Question: Which kind of chart has been used to present this data?
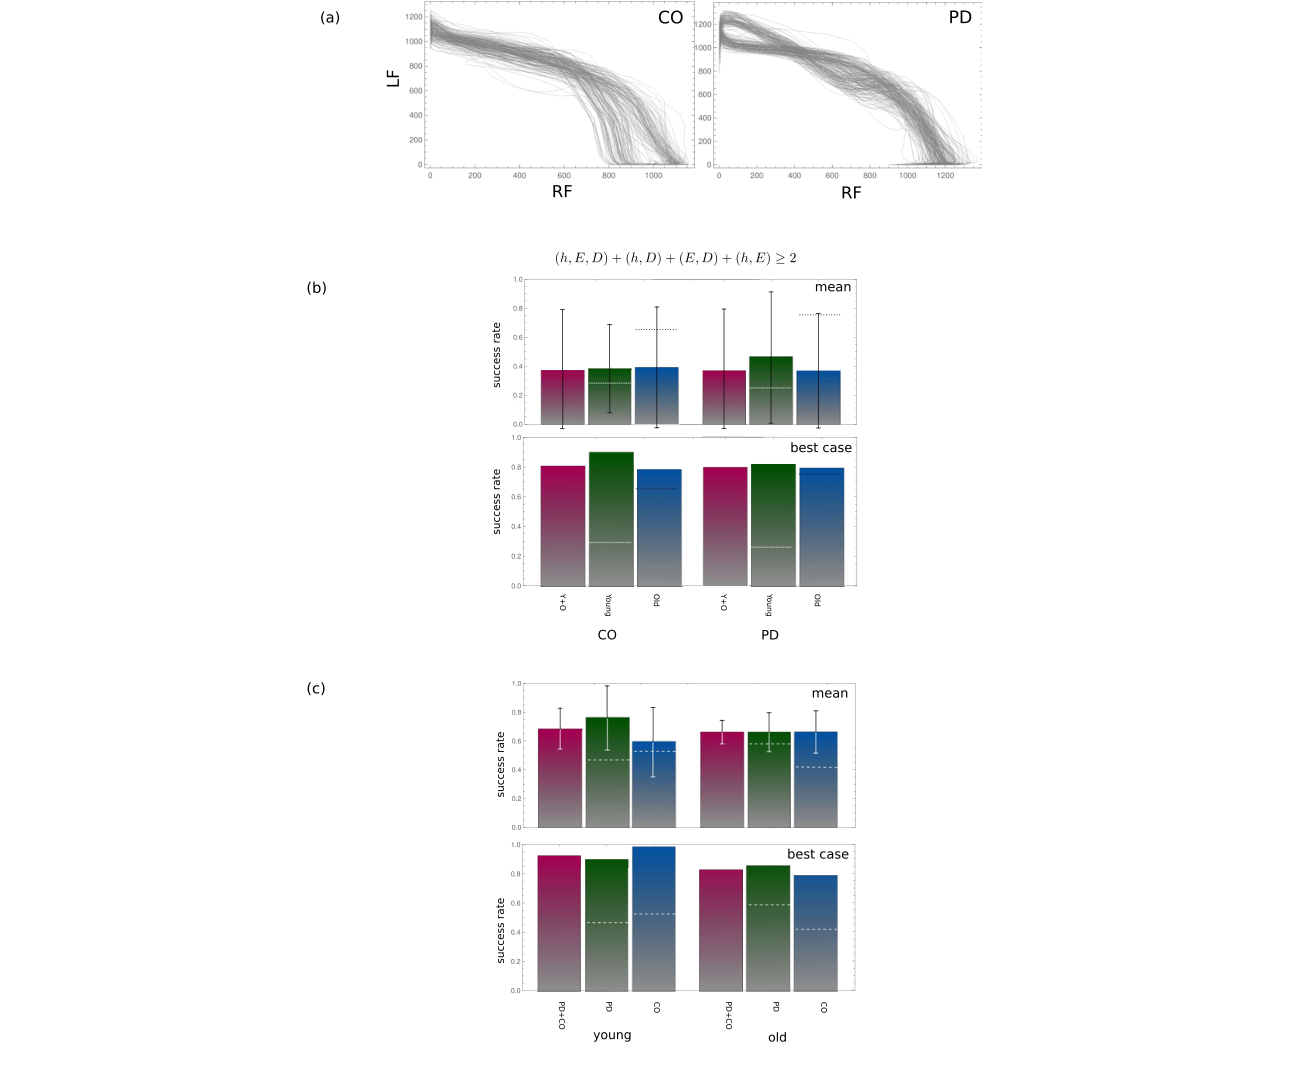
Answer: line